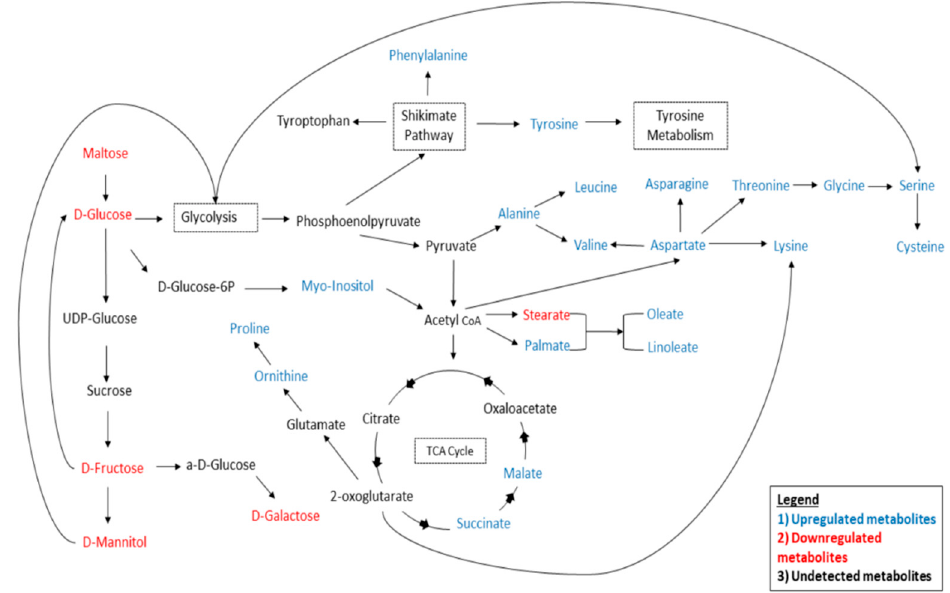
Figure 4. Metabolic changes mapped on metabolic pathways during fermentation of BSG by B. Subtilis WX-17. Colored labels indicate the respective increase, decrease, or undetected levels of metabolites at each given time.